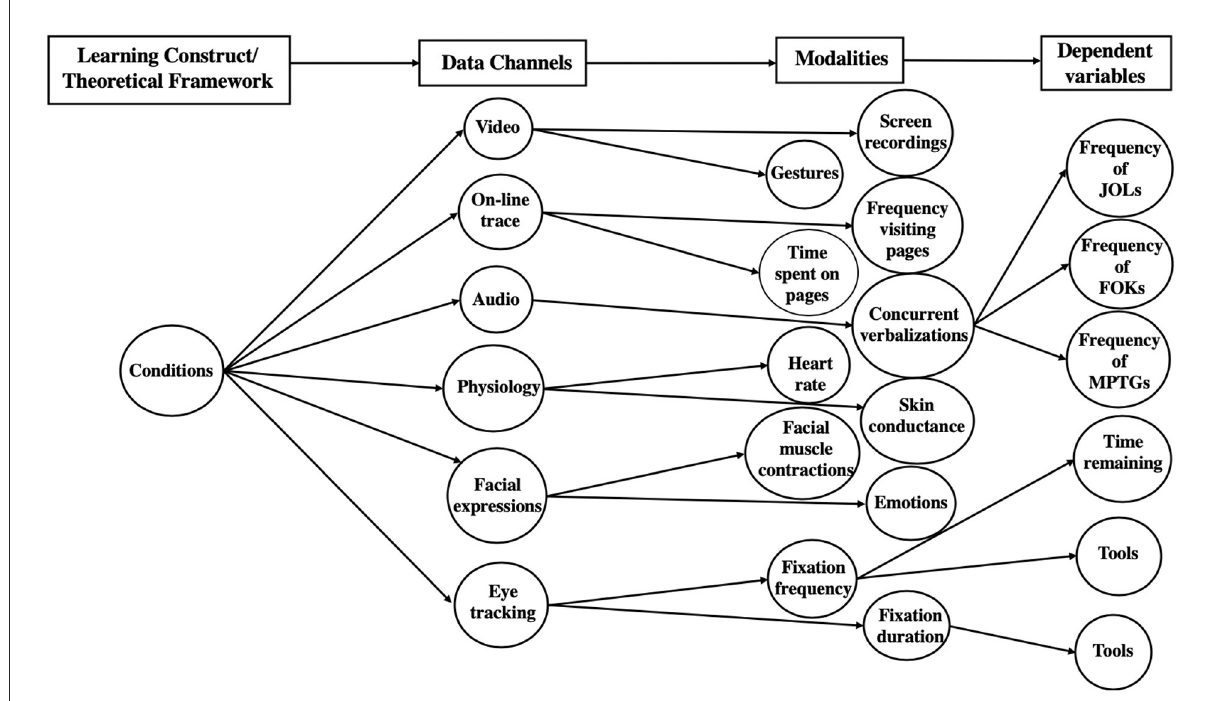
FIGURE4 Pipeline architecture for capturing conditions using Winne’s model. JOL, judgment of learning; FOK, feeling of knowing; MPTG, monitoring progress toward goals.